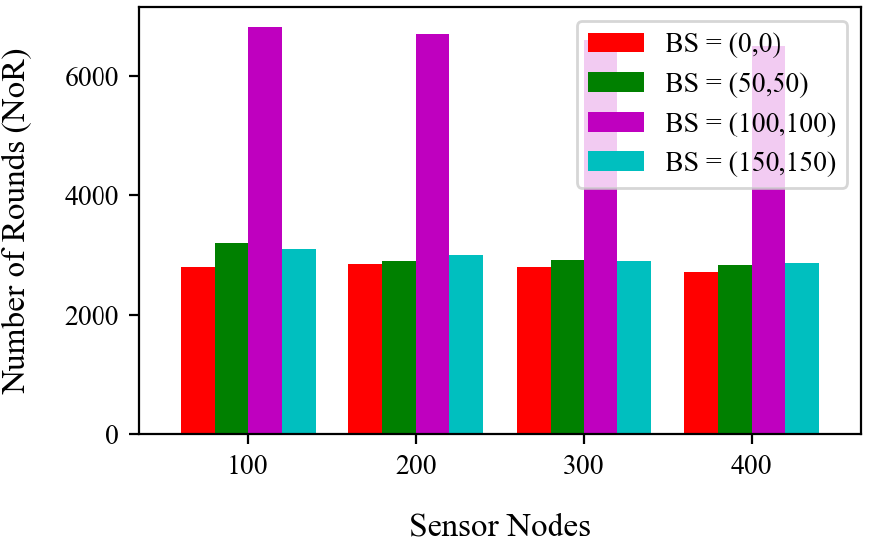
Figure 7. Impact of BS on the network lifetime.